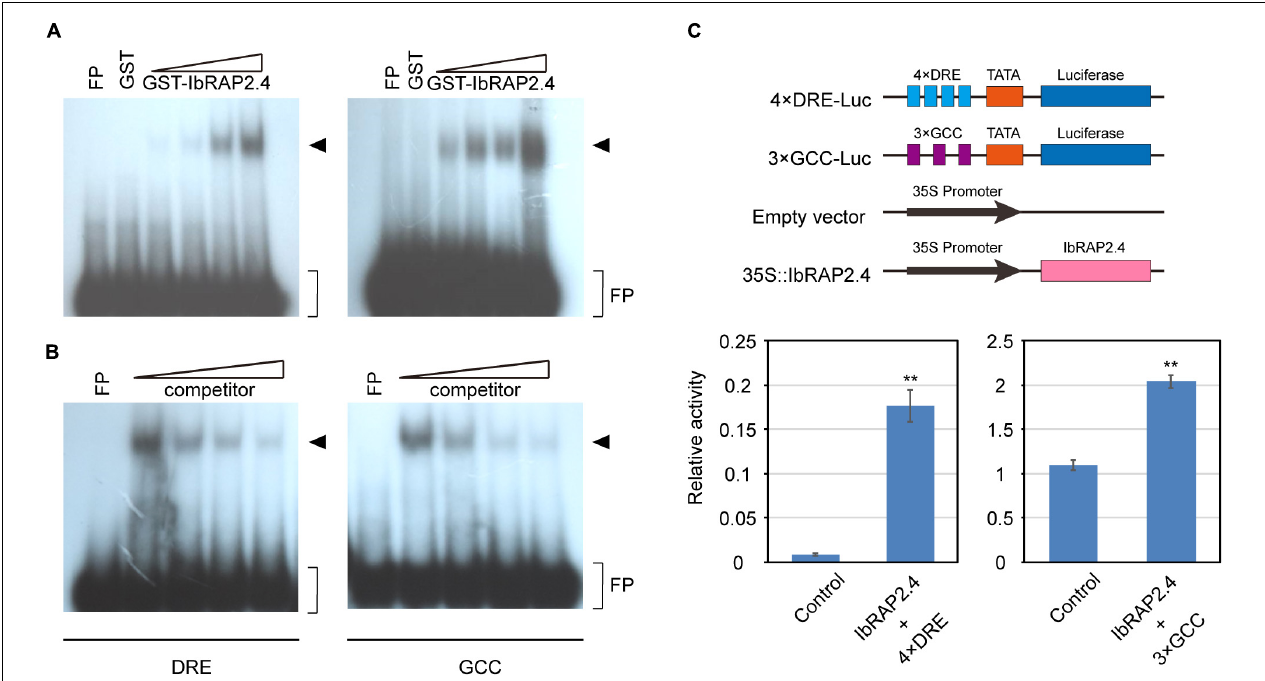
FIGURE 3 | Binding of IbRAP2.4 to the DRE element and GCC-box. (A) Dosage-dependent binding of GST-IbRAP2.4 to the DRE element and GCC-box. Triangles indicate increasing amounts of GST-IbRAP2.4 protein (0.5, 1.0, 2.0, and 4 µ g) used for DNA-binding analysis. The DNA-protein-binding complexes are indicated with an arrowhead. FP, free probe. (B) Competition analysis of unlabeled probe. Triangles indicate increasing amounts of unlabeled probe. The DNA-protein-binding complexes are indicated with an arrowhead. FP, free probe. (C) IbRAP2.4 activates the 4 × DRE-Luc reporter and the 3 × GCC-Luc reporter gene expression in Arabidopsis protoplasts. Bars represent standard deviations of triplicate experiments. Asterisks indicate significant differences between control and effector at ** P < 0.01.